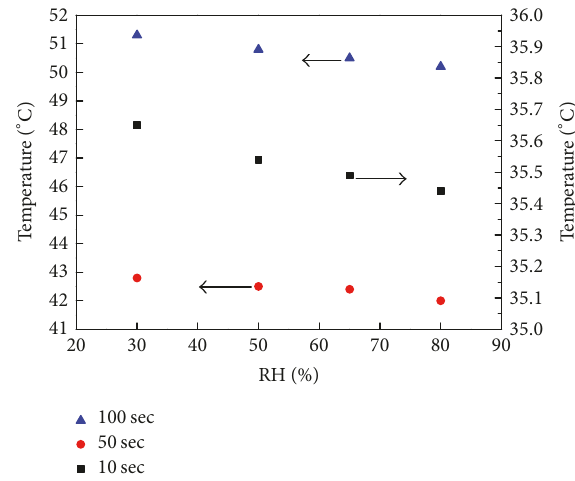
Figure 15: Temperature at skin